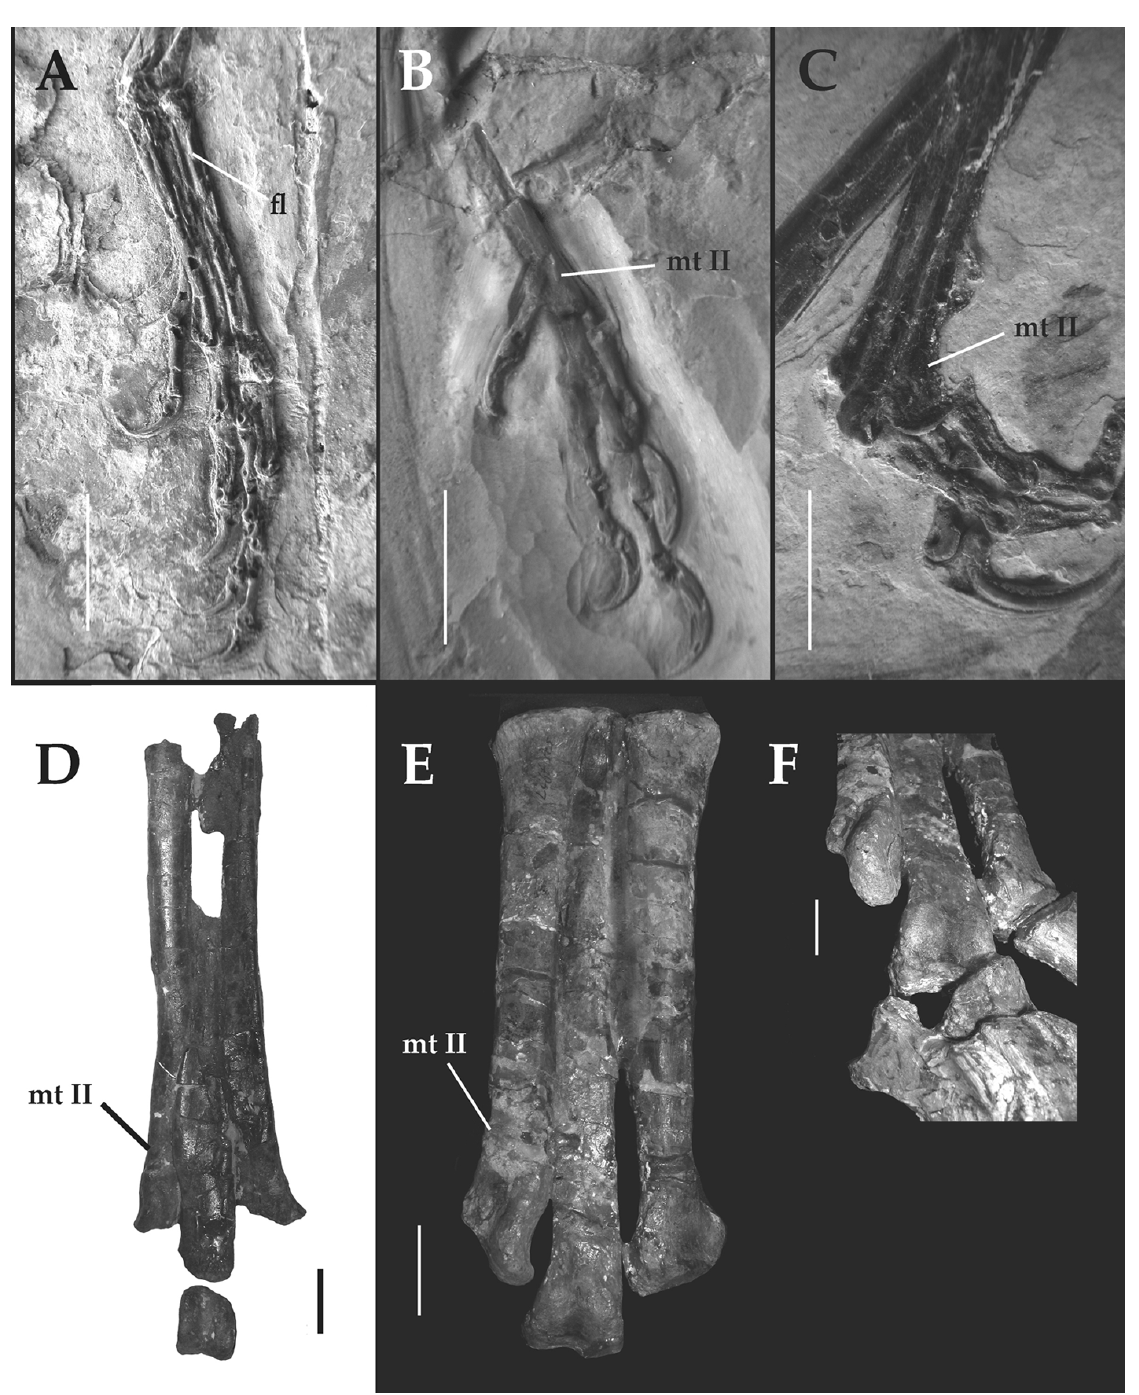
Fig. 4 – Metatarsus of: A , Jeholornis prima (IVPP V 13350) right metatarsus in posterior view; B , Archaeopteryx lithographica (HMN, 1880) left metatarsus in lateral view; C , Microraptor gui (IVPP V 13320) distal end of left metatarsus in anterior view; D , Unenlagia comahuensis (= Neuquenraptor argentinus Novas and Pol 2005; MCF PVPH, 77; holotype) distal end of left metatarsus in anterior view; E-F , Deinonychus antirrhopus (MCZ 4371) left metatarsus in: E , anterior view; F , distal view. Scale bar 2 cm. Abbreviations : lf, posterior longitudinal flange of metatarsal IV; mt, metatarsal; I, II, III, metatarsal